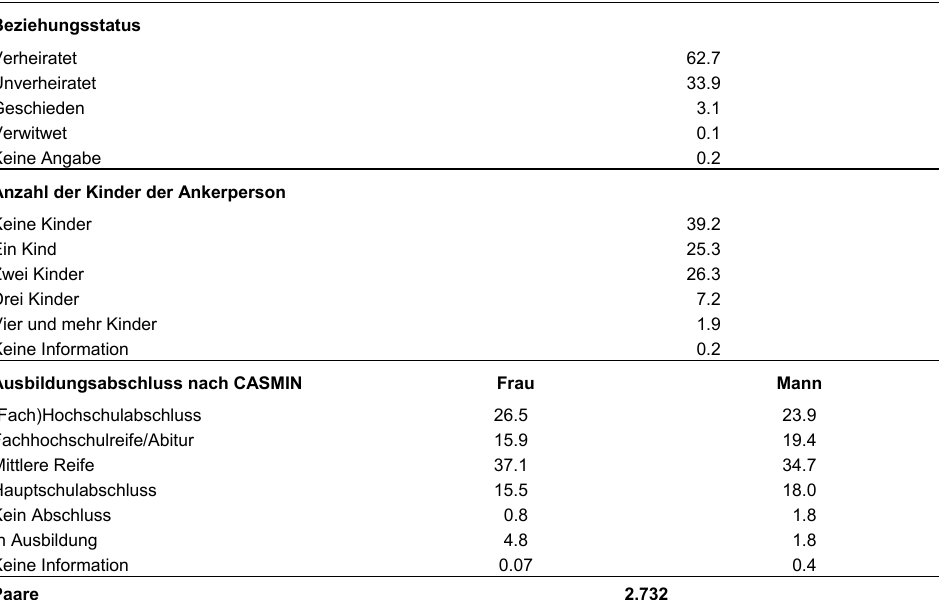
Tabelle 1 : Verteilung der demographischen Daten je Paar zum Zeitpunkt der